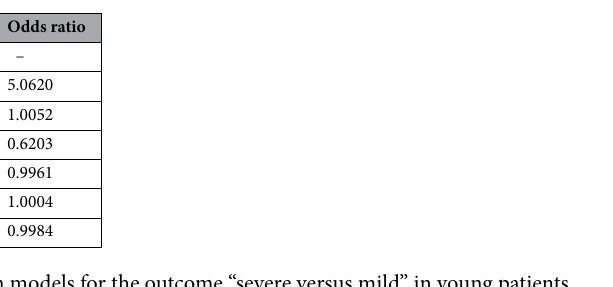
Table 3. Multivariable logistic regression models for the outcome “severe versus mild” in young patients selected using the AIC criterion and forward